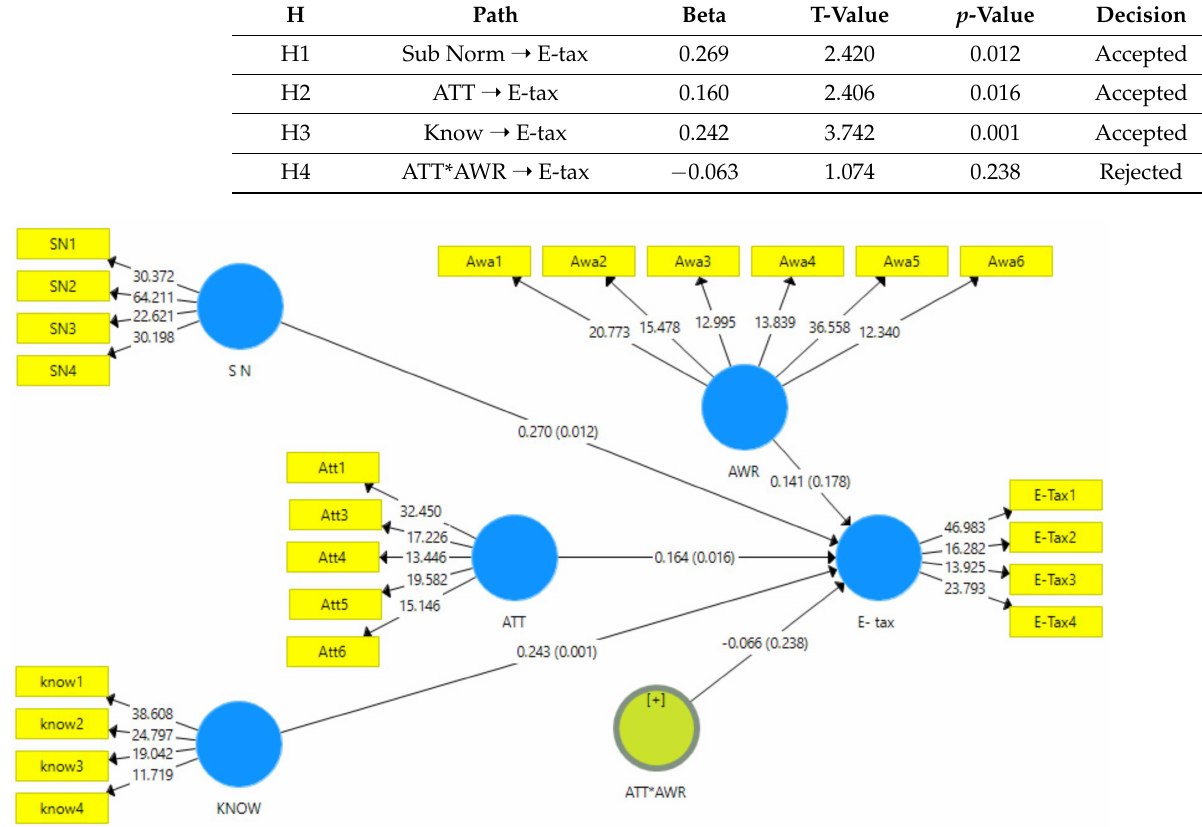
Figure 2. Structural